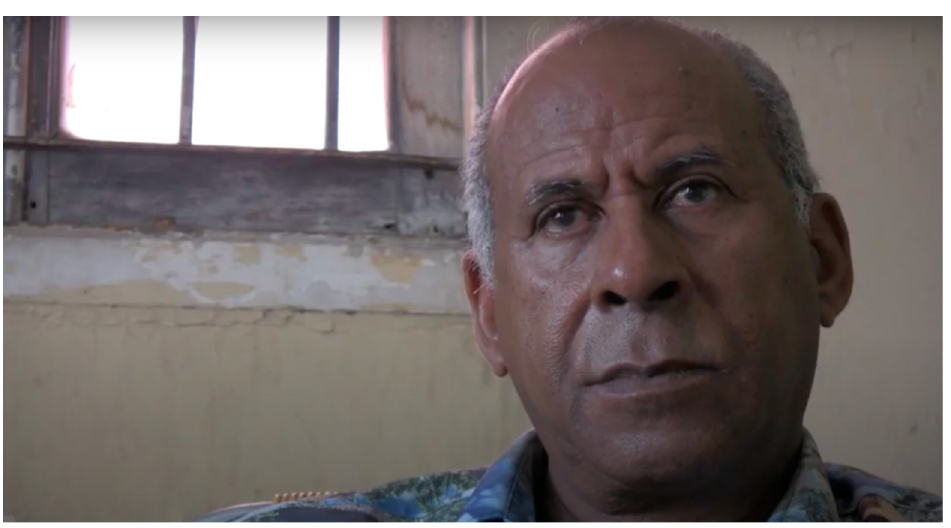
Figure 2. Juan García Fernández (aka Odufora). Lawton, La Habana, Cuba. April 2008. Asked to narrate and contextualize the story of the orisha song he had written, García began with a long pause, sitting very still for nearly a minute as he gathered his thoughts in silence.